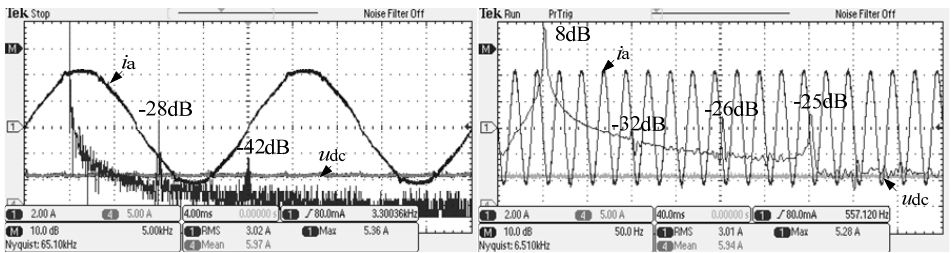
Figure 14. System AC current FFT analysis of the new split inductor solution 1.